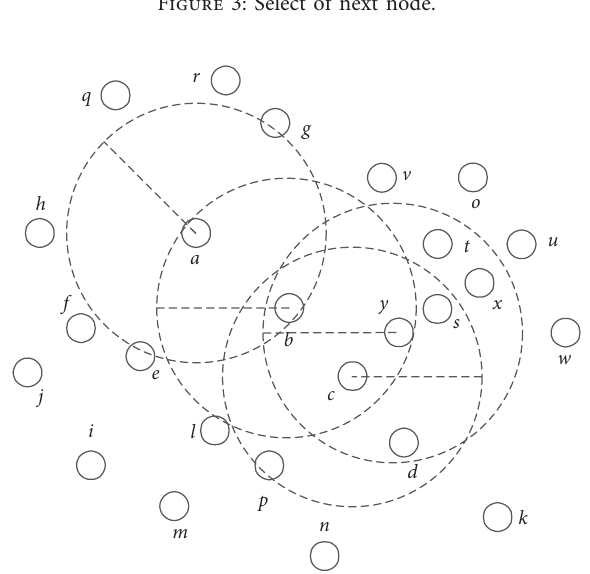
Figure 4: P function